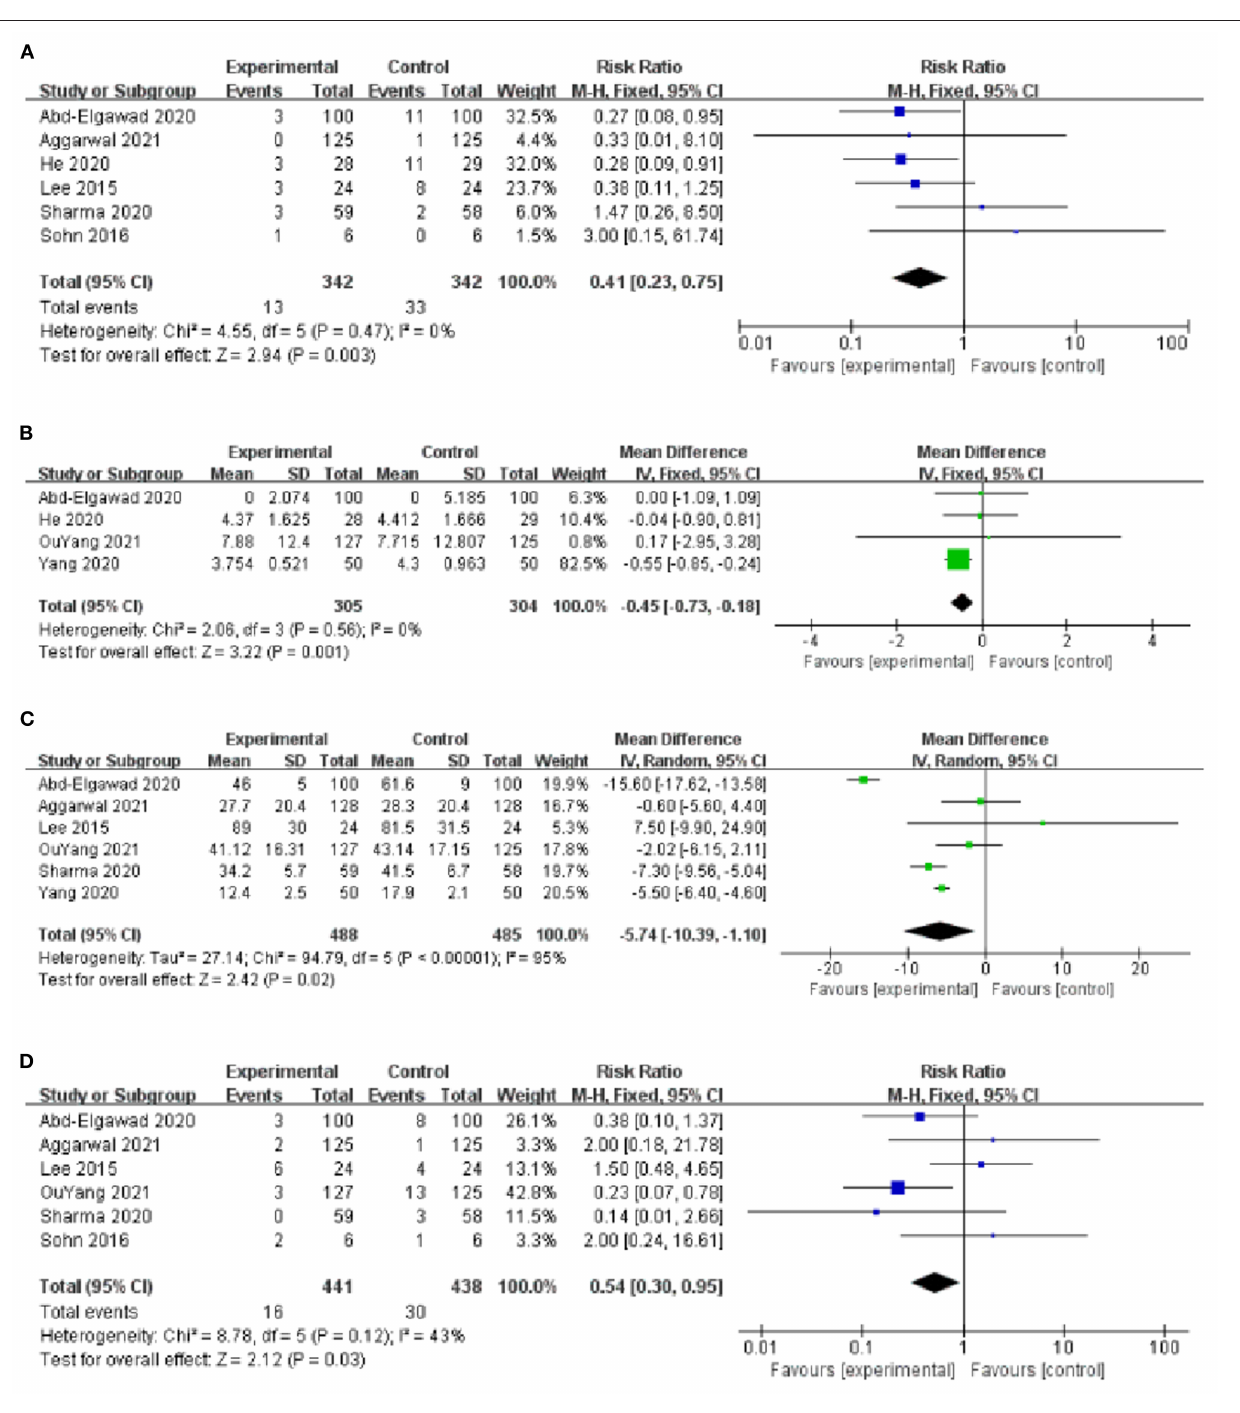
The Incidence of NEC Six studies provided data on the incidence of NEC (9, 10, 13–16), with moderate heterogeneity among studies ( I 2 = 43%, P = 0.12) and using a fixed-effect model analysis. The results showed that